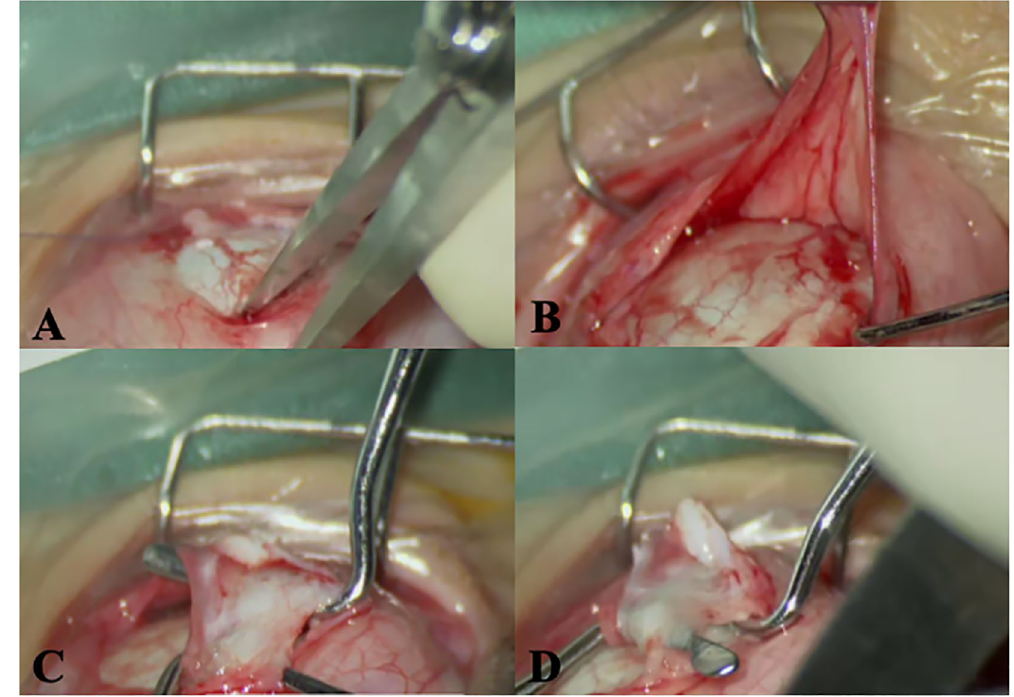
Figure 1. Extraocular muscle abnormalities of craniosynostosis. ( a , b ) IR absence, ( c ) LR wedge-shaped deformity, ( d ) LR ectopic and adhesion to the lower